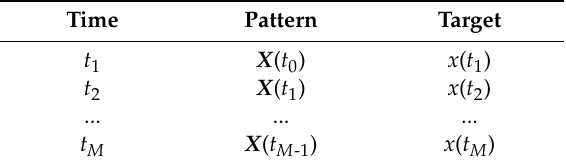
Table 1. The pattern-target samples extracted from photovoltaic (PV) power chaotic time